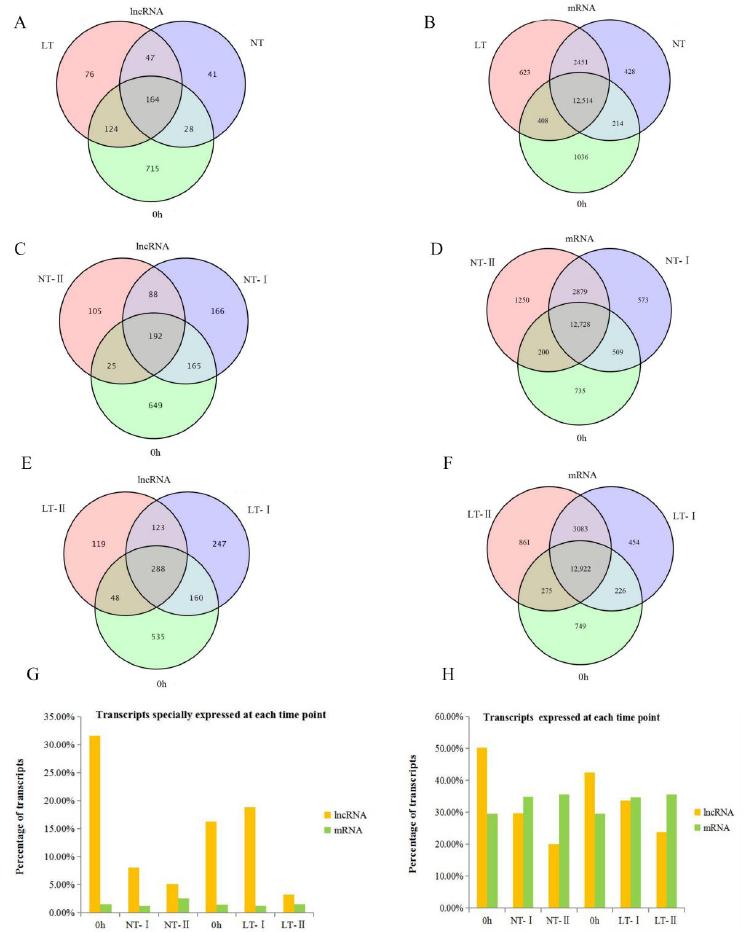
Figure 4. The characteristics of the expression of lncRNAs and mRNAs during seed germination under NT and LT. ( A ) Venn diagram of expressed lncRNAs under NT (NT-I, NT-II), LT (LT-I, LT-II) and 0 h. ( B ) Venn diagram of expressed mRNAs under NT (NT-I, NT-II), LT (LT-I, LT-II) and 0 h. ( C ) Venn diagram of lncRNAs expressed under NT. ( D ) Venn diagram of mRNAs expressed under NT. ( E ) Venn diagram of lncRNAs expressed under LT. ( F ) Venn diagram of mRNAs ex- pressed under LT. ( G ) Percentage of specifically expressed lncRNAs and mRNAs at different stages of NT and LT. ( H ) Percentage of totally expressed lncRNAs and mRNAs at different stages of NT and LT. Further analysis was performed to compare the expressed lncRNAs and mRNAs at different stages of germination. The Venn diagrams in Figure 4C – F indicate the expressed lncRNAs and mRNAs in different stages of NT and LT. Under NT and LT treatments, the proportion of total expressed lncRNAs decreased from the 0 h time point to stage II, but